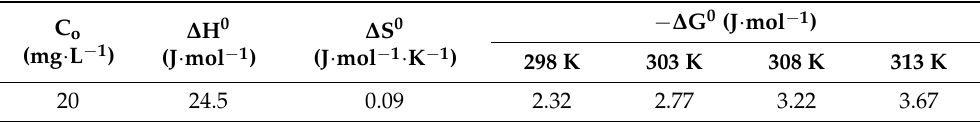
Table 4. Thermodynamic parameters for the adsorption of Cd(II) onto XG-cl-poly(AAm-co-AA)